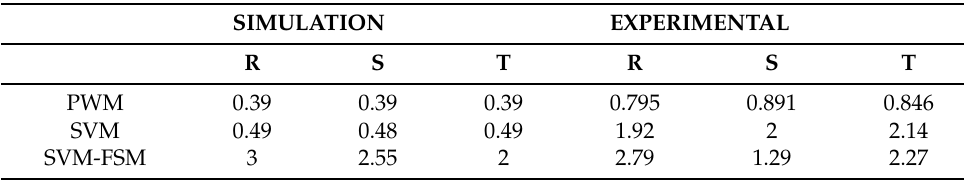
Table 7. THD (%), f sw = 2000